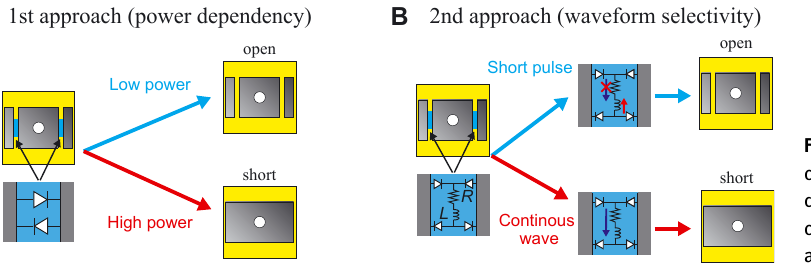
Figure 4: Mushroom unit cell with (A) a cir- cuit containing a pair of PIN diodes for power dependency, and (B) an inductor-based cir- cuit for waveform selectivity. Circuit values are given by R = 5.5 Ω and L = 100 μ